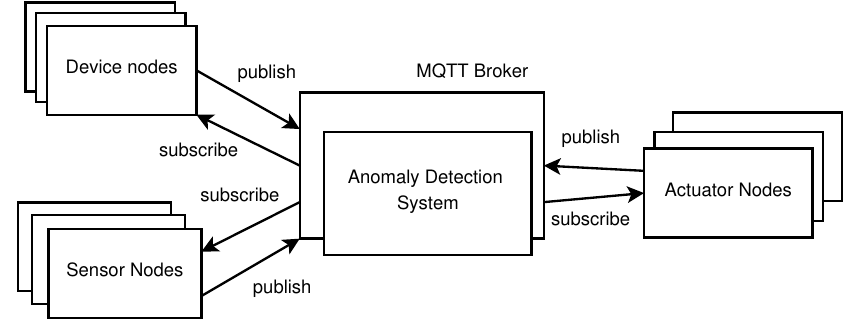
Figure 4. Overview of an IoT system with anomaly detection